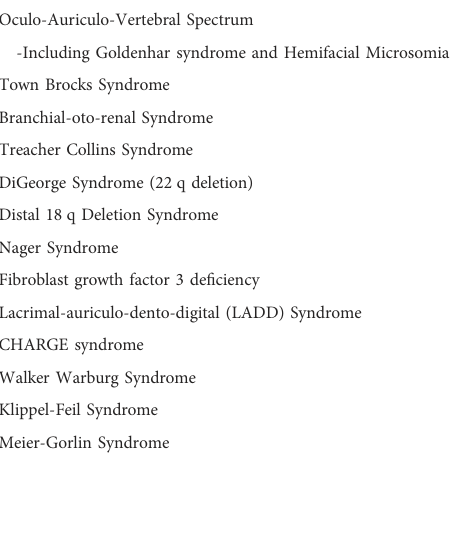
TABLE 1 Syndromes commonly associated with microtia.